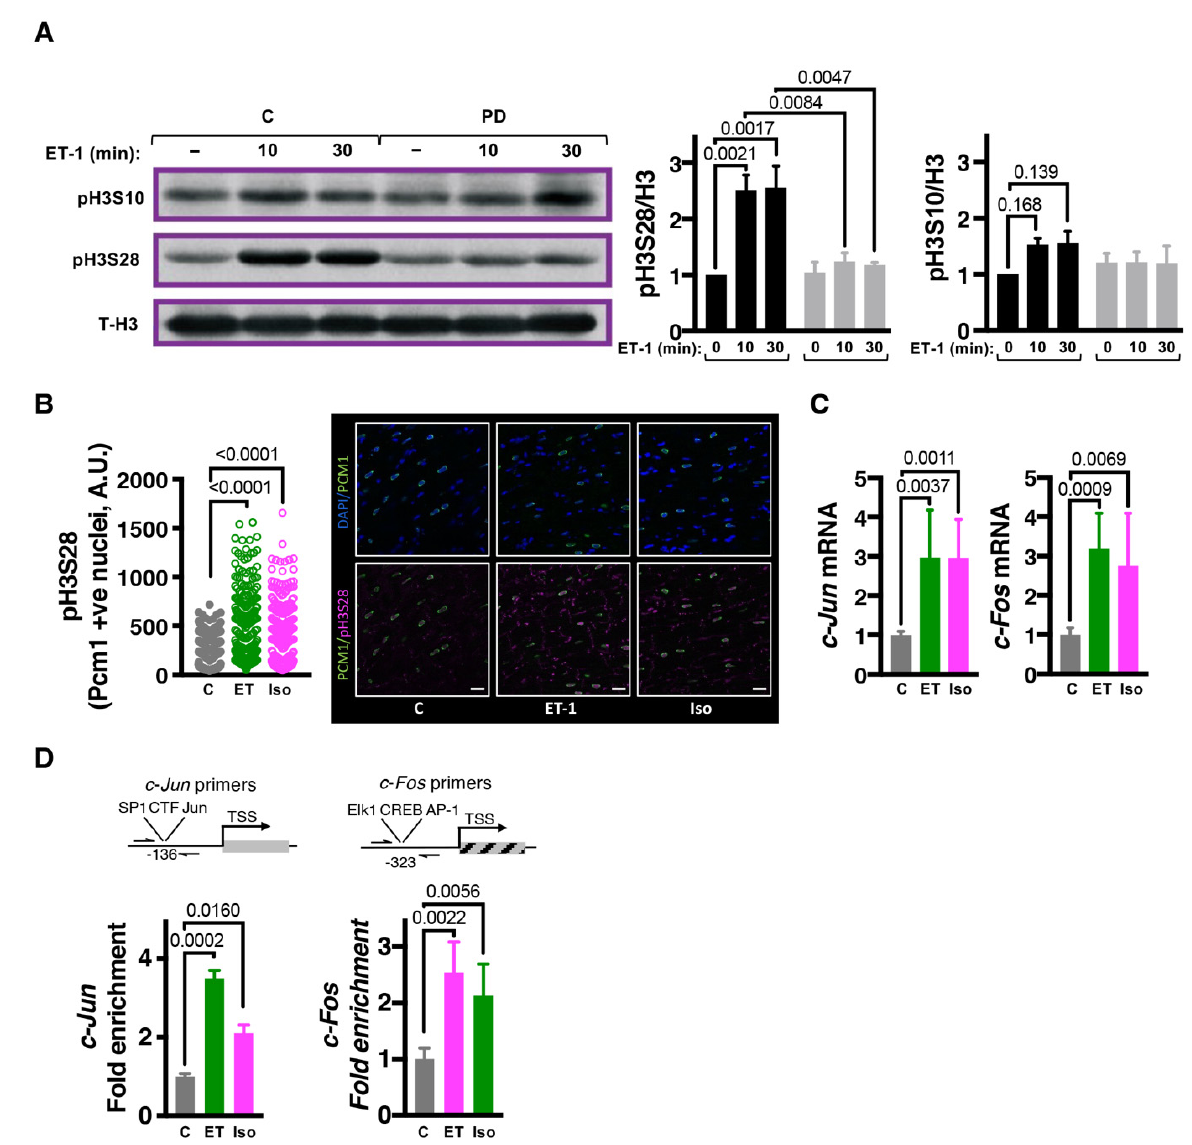
Figure 1. Neurohumoral signalling-induced ERK1/2 activation results in histone H3S28 phosphorylation at IEG promoters. ( A ). Immunoblot analysis of pH3S10 and pH3S28. Left: Representative immunoblots from 1 NRVM preparation probing for pH3S10 and pH3S28 in acid-extracted histones from NRVMs exposed to ET-1 for 0, 10 and 30 min in the presence or absence of PD. Right: Levels of phosphorylated histone normalised to total histone H3. For pH3S10, N = 5. For pH3S28, N = 3. ( B ). Confocal immunofluorescence analysis of pH3S28 in CM in ventricular cardiac sections prepared from rats infused with ET-1 or Iso for 15 min. CM nuclei were demarcated by pericentriolar material 1 (PCM-1; in green) perinuclear staining. Nuclei are stained with DAPI (blue) and pH3S28 in magenta. Scale bar = 25 µm. The plot ( left ) shows quantification of nuclear pH3S28 in PCM-1 positive nuclei. N = 4, 80–125 nuclei per animal. ( C ). RT-qPCR gene expression analysis of IEGs c-Jun and c-Fos mRNA in left ventricular tissue from Wistar rats administered with ET-1 or Iso through jugular vein infusion and sacrificed 15 min later. N = 7, 8 and 6 for control, ET-1 and Iso infused animals respectively. ( D ). Chromatin immunoprecipitation-qPCR (ChIP-qPCR) analysis of pH3S28 at IEG promoters , c-Jun and c-Fos in adult male Wistar rats that were administered ET-1 or Iso through jugular vein infusion and sacrificed 15 min later. Top : schematic for the site of ChIP primer amplification relative to the transcription start sites. Below : quantification of enrichment compared with control (untreated) rats. N = 3.